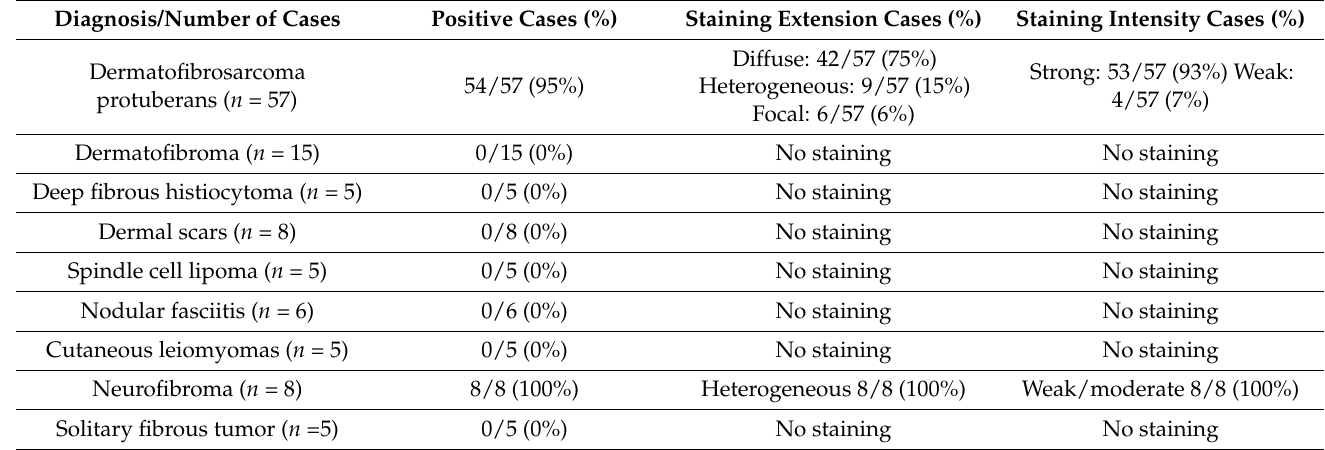
Table 1. Summary of the immunohistochemical